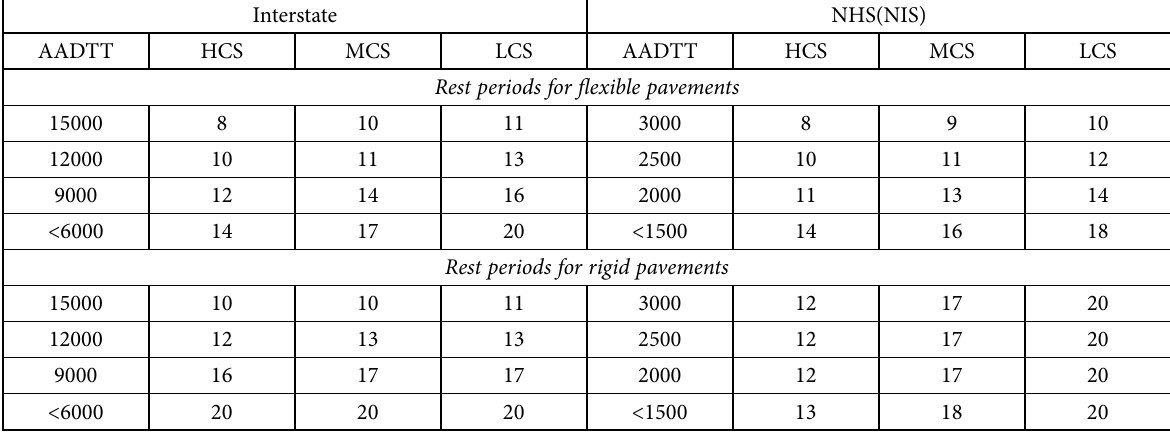
Table 3. Rest periods for flexible and rigid